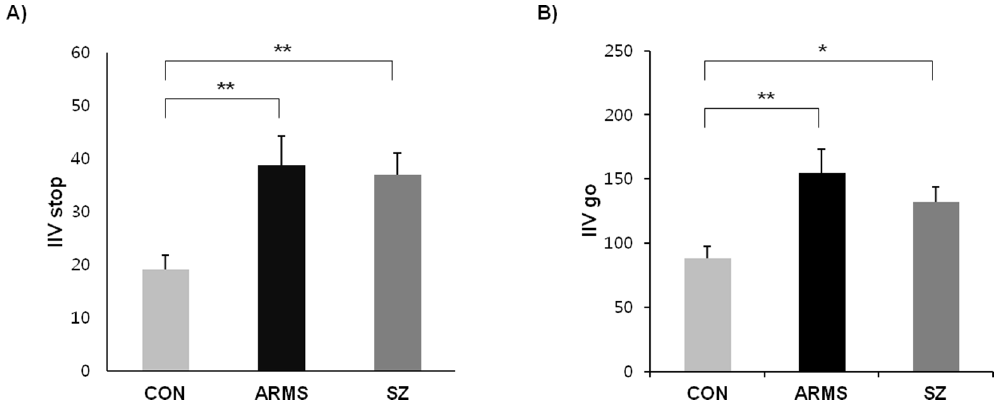
Figure 1. Mean performances of normal controls, ARMS subjects and schizophrenia patients on stop-signal task. A) Intra-individual variability (IIV) in stop process; B) Intra-individual variability (IIV) in go process. Note. CON = control; ARMS = at-risk mental state; SZ = schizophrenia.